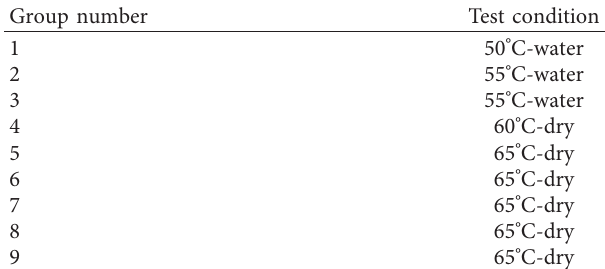
Table 4: Test conditions of different specimens. Group